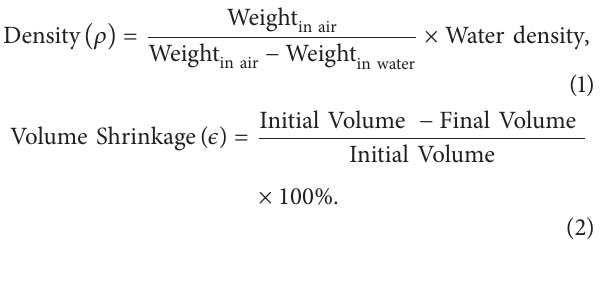
(TN/CS) and Ti-6Al-4V/CaSiO 3